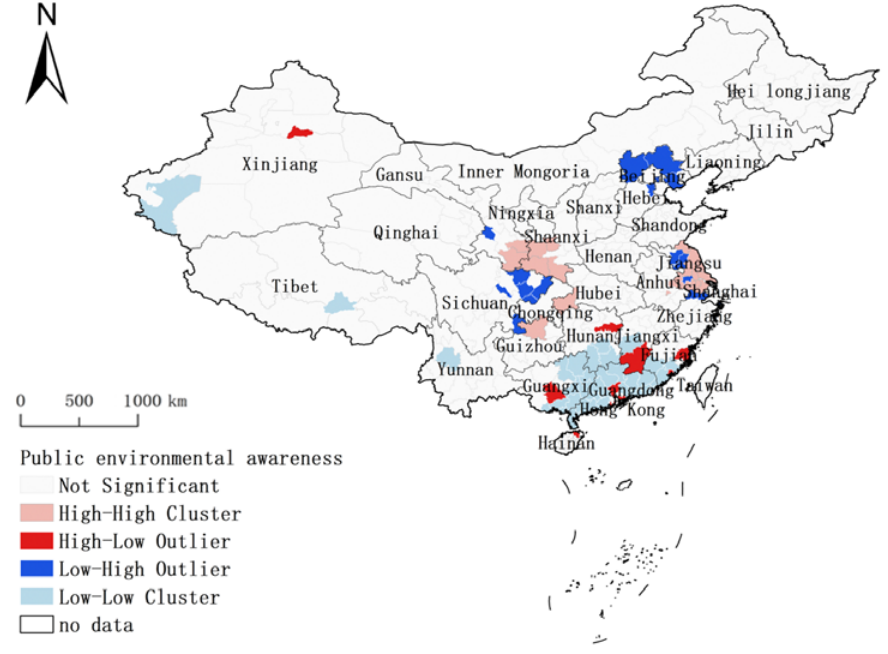
Figure 4. The spatial agglomeration of public environmental cognition.